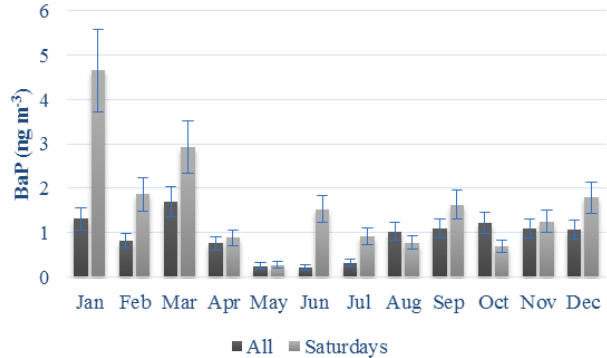
Figure 5. Monthly mean BaP concentrations together with monthly mean concentrations on Saturdays at the detached-house area around the measurement site DH6 in Helsinki in 2013. Error bars show the measurement